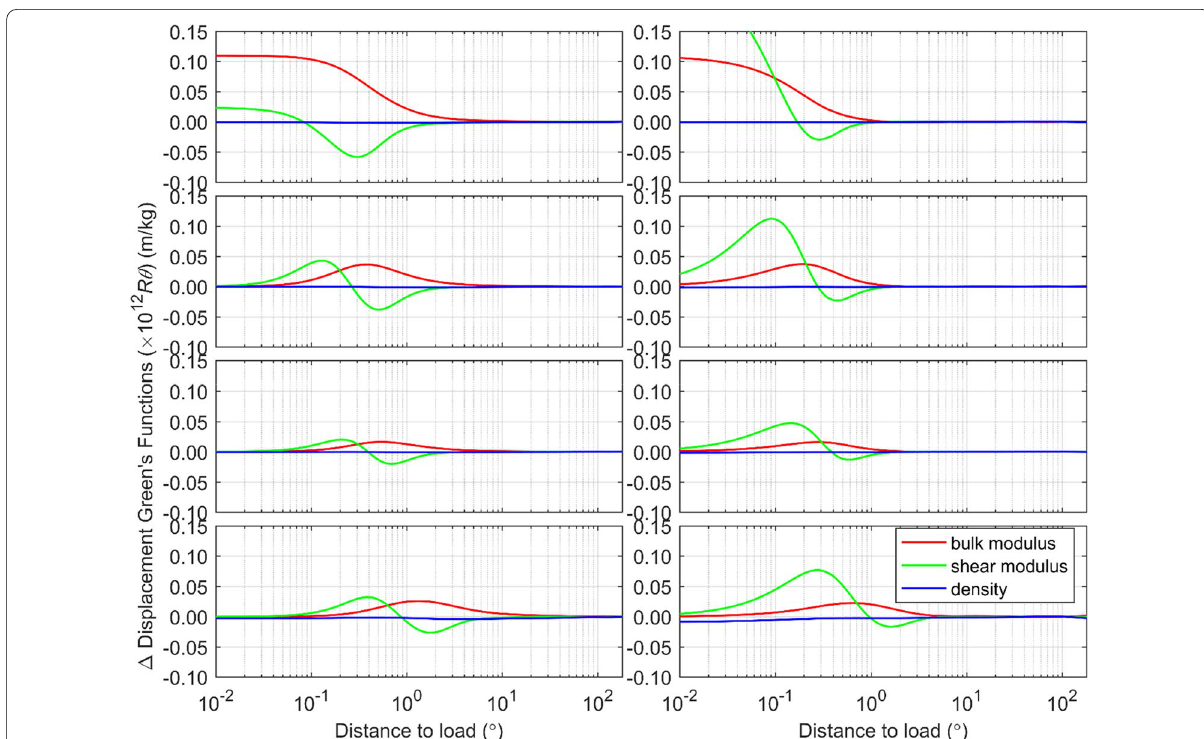
Fig. 3 Differences between the original and perturbed displacement Green’s functions. The differences of displacement Green’s functions for the horizontal (left) and vertical (right) components to 1% linear perturbations of the bulk modulus (red), shear modulus (green), and density (blue) + in the upper crust at depths of 0–13.88 km (top row), the middle crust at depths of 13.88–24.52 km (second row), the lower crust at depths of 24.52–32.15 km (third row), and the region above the LVZ (LID) at depths of 32.15–80 km (bottom row) separately from TW1 as a function of angular distance. The displacement Green’s functions are scaled by 10 12 Rθ in the CE frame, where R is the radius of the Earth and θ is the angular